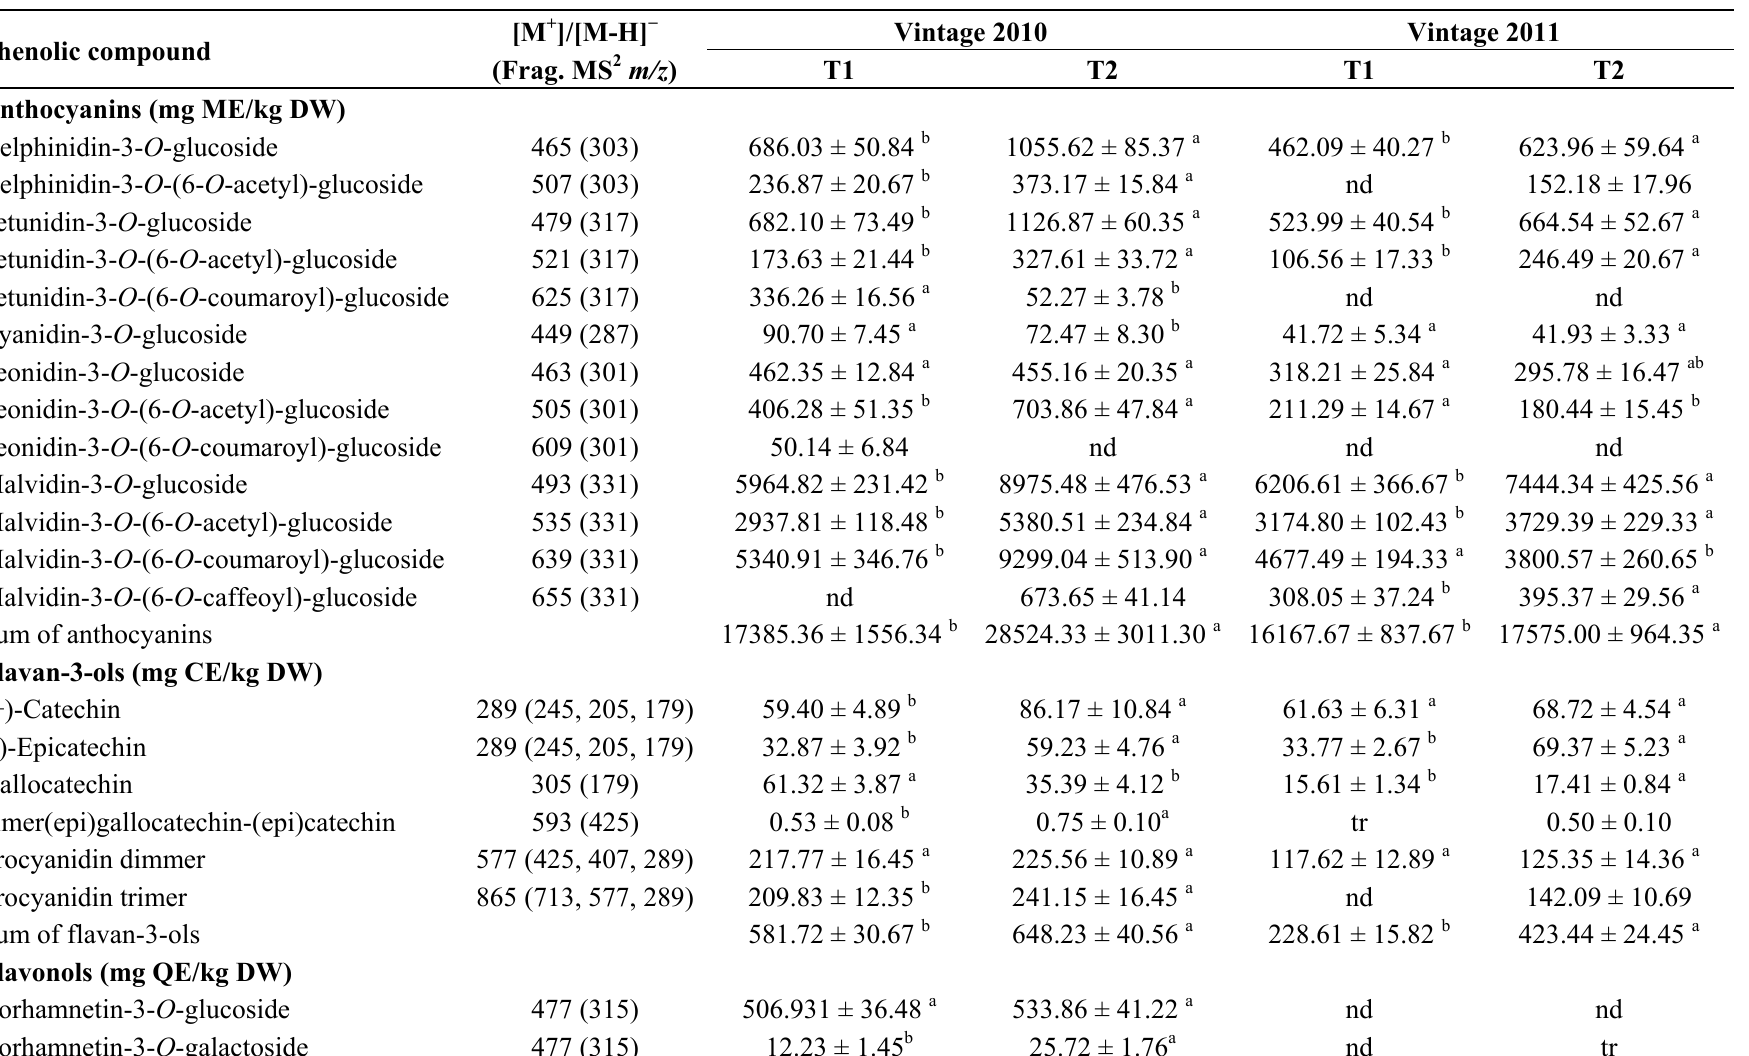
Table 4. Phenolic profiles of berry skins under rain-shelter cultivation (T1) and open-field cultivation (T2) in the 2010 and 2011 vintages. Phenolic